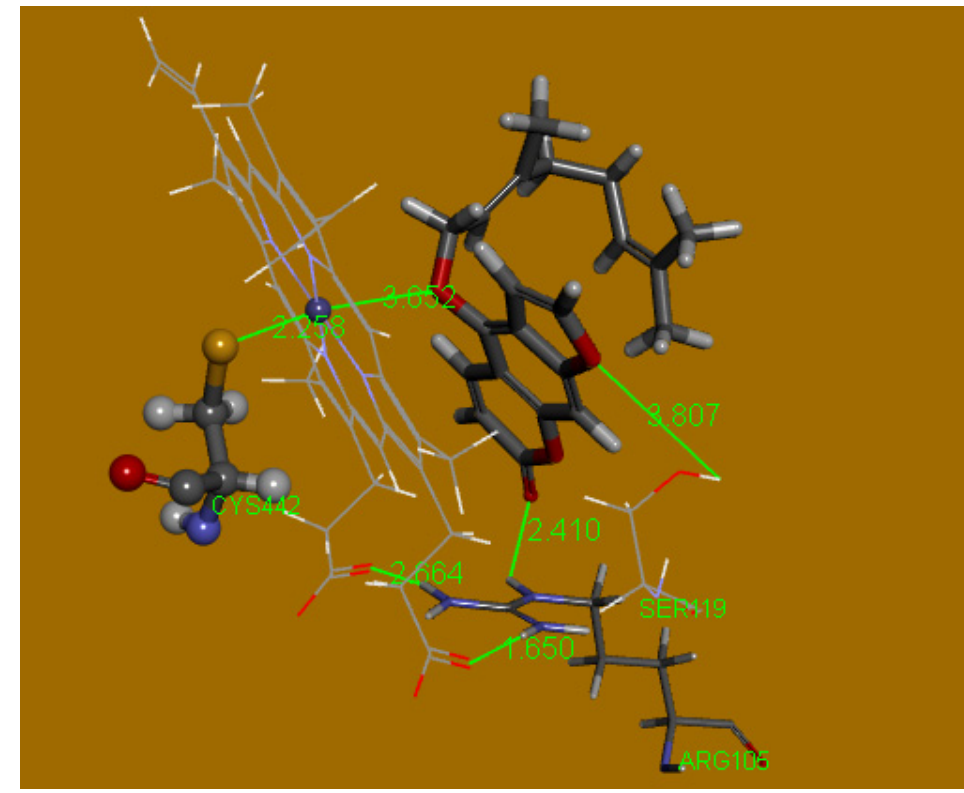
Figure 7. Pose 6 shows π – π co-planarity between the flat bergamottin ring system and the protein heme. Arg − 105 establishes three additional important H-bond interactions: Arg − 105 NH ... O(coumarin carbonyl) and 2 H-bonds, with both heme carboxylates, through both terminal NH 2 groups. S(Cys − 442) completes the Fe coordination sphere from the protein. The geranoxy O(bergamottin) forms an angle of 151 ◦ with Fe, and is 3.652 Å apart, which may be thought to establish the 6th coordination site of the iron coordination sphere. A related DFT study of this system will be later